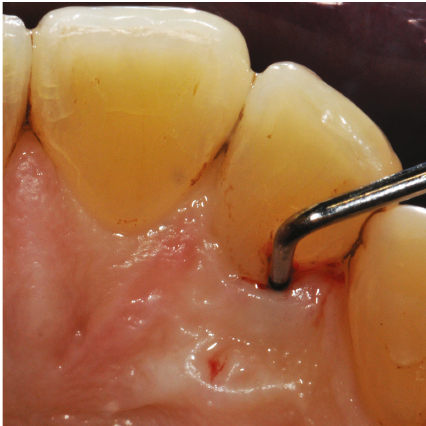
Figure 1: Clinical examination revealed the presence of a 13 mm deep periodontal pocket associated with an enamel alteration on the palatal side of 1.2.